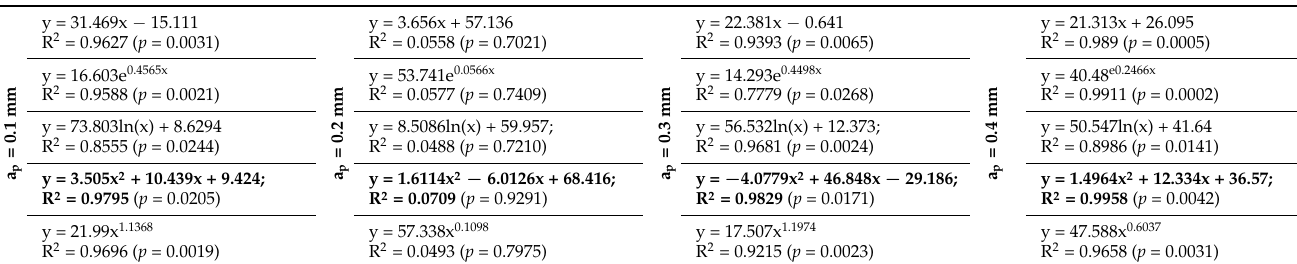
Table 4. Results of mathematical modelling of the Sz parameter as a function of the feed rate for different values of the depth of cut (regression functions y = Sa(f z ); f z = x with the coefficient of determination R 2 ).